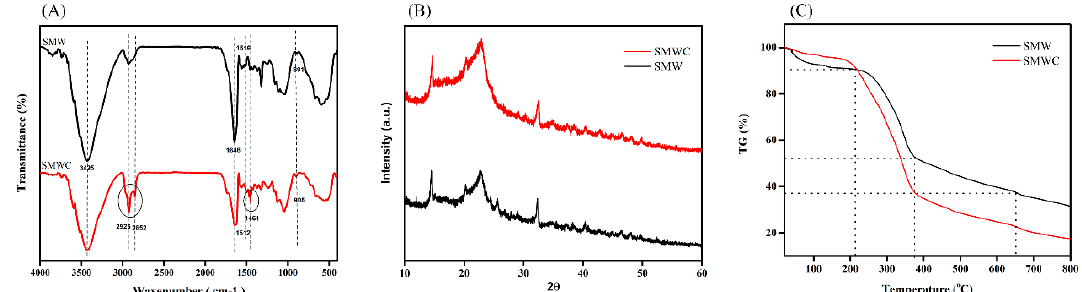
Figure 1. FTIR spectra of spent mushroom waste (SMW) and SMW modified by cetyltrimethylammonium bromide (SMWC) ( A ); X-ray diffraction patterns of SMW and SMWC ( B ) and the TGA of SMW and SMWC (C).